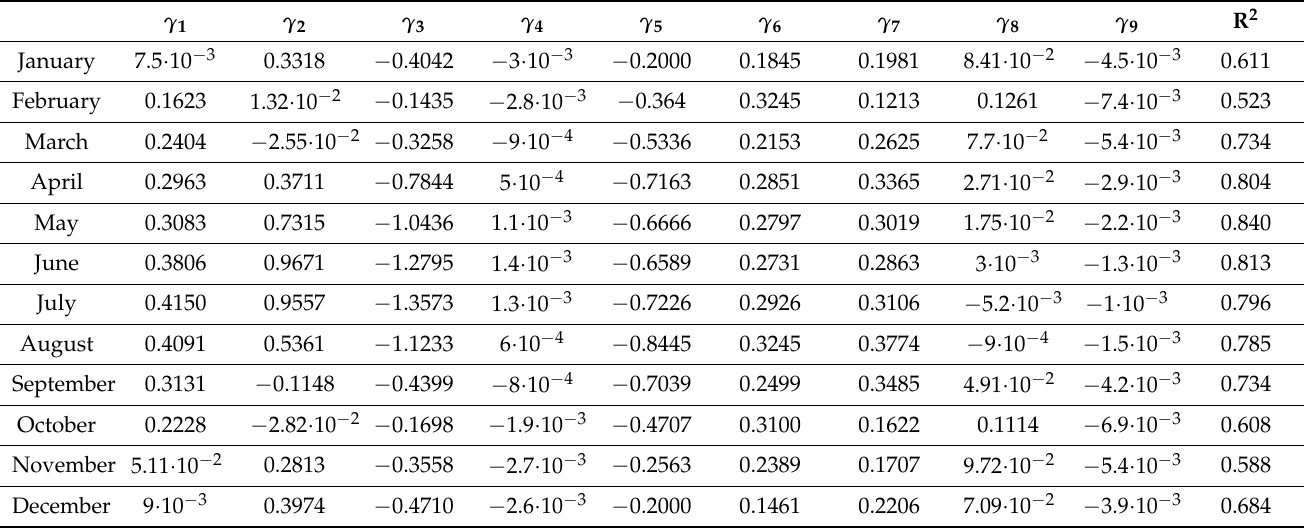
Table 4. Coefficients corresponding to the adjustment of Equation (32) for the prediction of solar radiation in the intercollector space for the representative day of each month of the